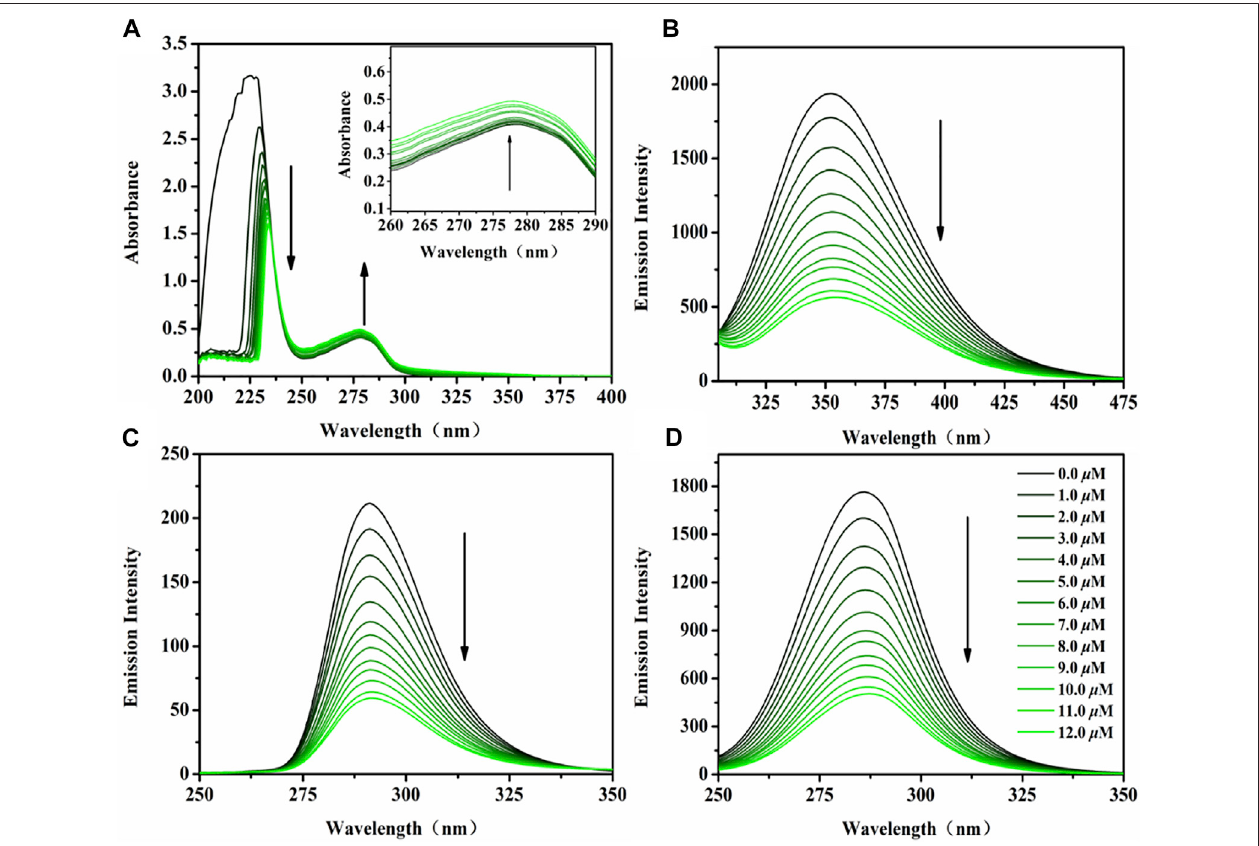
FIGURE3 |(A) UV-vis spectraofBSA(10 μ M) hatched withIr2 (0 – 12 μ M) inTris-HCl solution.Inset: Wavelength from 260to 290 nm; (B) The emission spectra of BSA (10 μ M) hatched with Ir2 (0 – 12 μ M) in Tris-HCl solution; Synchronous fl uorescence spectra of BSA (10 μ M) hatched with Ir2 (0 – 12 μ M) at a wavelength interval of 15 nm (C) and 60 nm (D) ; Arrow shows the intensity change upon increasing Ir2 concentration.